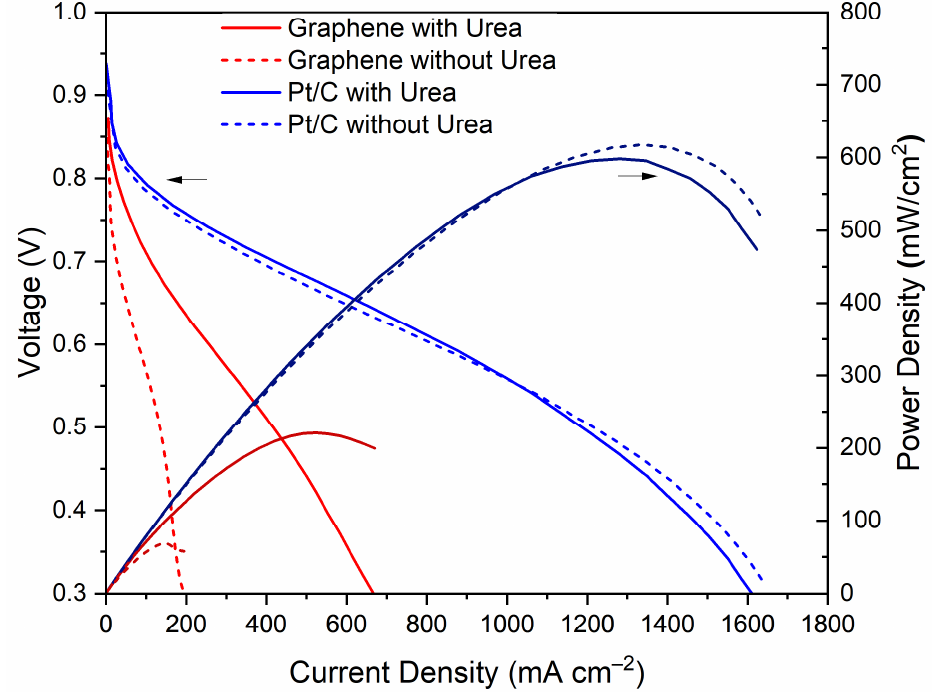
Figure 4. Polarisation and power density curves of graphene-based (in red) and commercial carbon black (in blue), tested in 25 cm 2 MEAs, under H 2 /air, with no backpressure. The solid lines represent the MEAs that were manufactured with urea, while the dashed lines correspond to the MEAs without urea added to the ink.